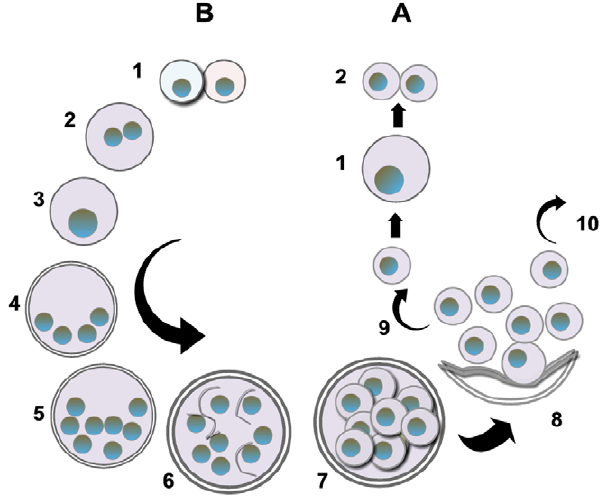
Figure 1. Putative life cycle of Pneumocystis . The entry of Pneumocystis into the mammalian lung likely occurs during the first year after birth. The agent of infection is suspected to be airborne spores. Recent studies suggest that the cyst/ascus (containing eight spores) may be the agent of infection [9]. After inhalation, the spores ultimately take residence in the terminal portion of the respiratory tree, the alveoli. Neither the mechanism of migration to the alveoli nor the form in which the organism arrives in the alveoli (intact ascus or individual spores) is known. (A) Asexual phase: Haploid trophic forms are thought to replicate asexually by binary fission, whereby the nuclear content is duplicated (1) along with cellular contents that (2) divide into two haploid trophic forms. (B) Sexual phase: Two presumptive mating types conjugate (1), undergo karyogamy (2), and produce a diploid zygote (3) that progresses through meiosis to produce four haploid nuclei (4) followed by an additional mitosis to produce eight nuclei (5). The nuclei are packaged into spores by invagination of the ascus cell membranes (6) to produce eight double-membrane spores (7). After completion, excystment occurs via a protunicate release by unknown mechanisms (8). The released spores become the vegetative forms that can then undergo asexual (9) or sexual replication with a presumed opposite mating type (10). The mechanism of exit out of the lung and the life cycle form that transits into the environment are unknown (the life cycle was composed using SmartDraw 10, San Diego, California).